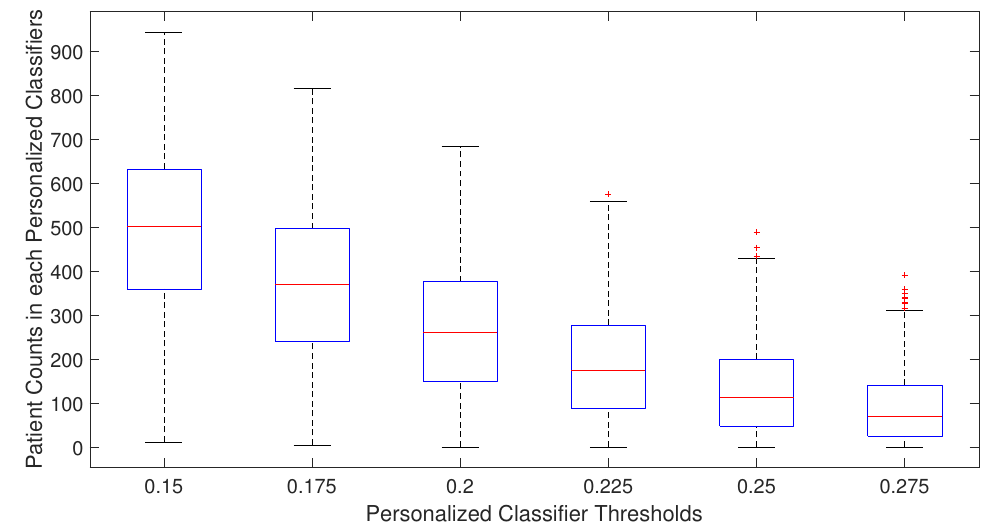
Figure 2. Number of patients used in training personalized classifiers for each patient for specific personalized classifier